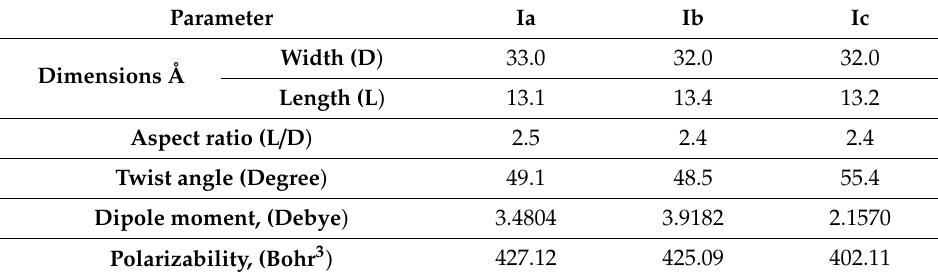
Table 3. Dimensional parameters and aspect ratios of estimated geometrical isomers of I.